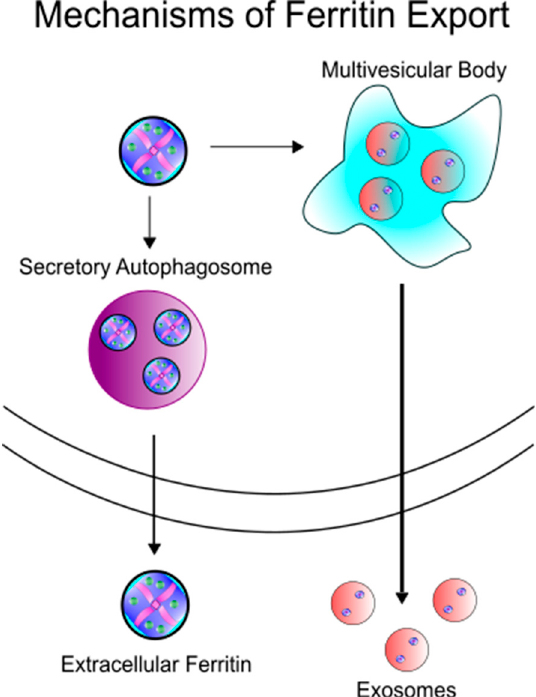
Figure 2. Schematic of iron export mechanisms. Ferritin has been hypothesized to be secreted in two different paradigms: (1) Ferritin is trafficked from the cell via secretory autophagy or (2) ferritin encapsulated in exosomes is released extracellularly from multivesicular bodies.